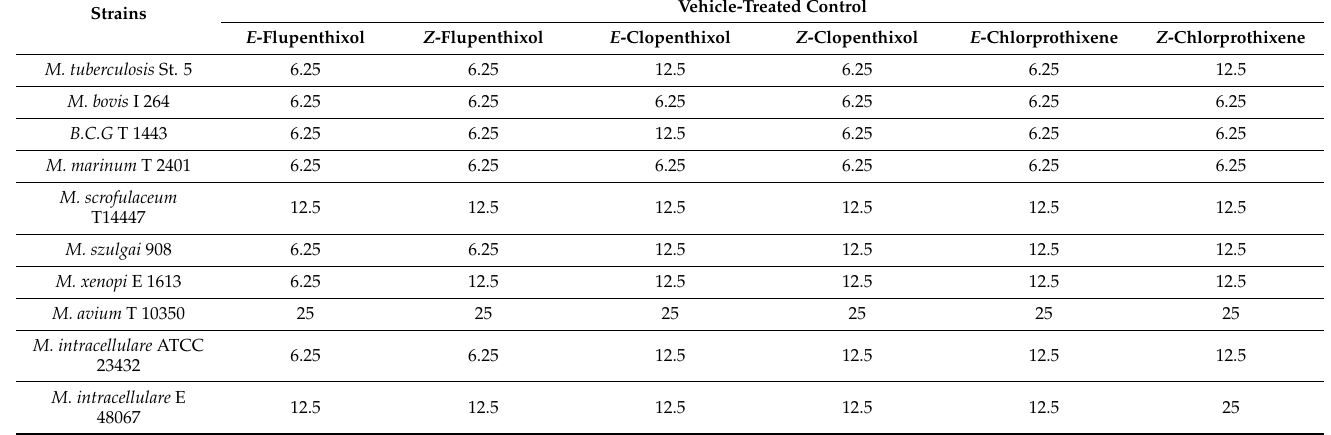
Table 7. The susceptibility of 10 slow-growing mycobacteria to 6 different Z - and E -thioxanthene derivatives.